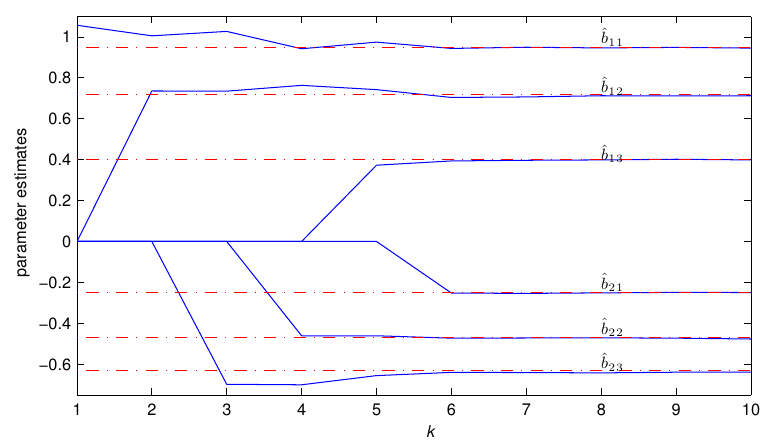
Figure 3. The estimation error δ versus iteration k ( m = 80, σ 2 = 0 . 10 2 ).